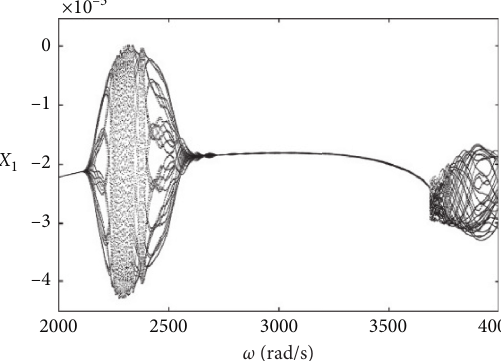
Figure 8: Bifurcation diagram of rotor with k